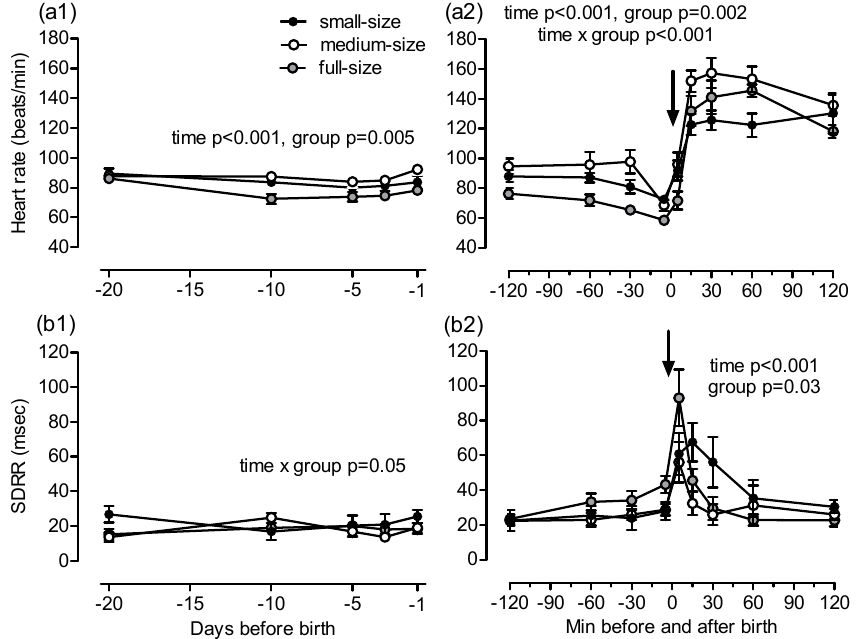
Figure 5. ( a ) Heart rate and ( b ) SDRR (standard deviation of the beat-to-beat interval) in small (Shetland), medium-size (Haflinger) and full-size (Warmblood) fetuses ( 1 ) during the last 20 days before birth and ( 2 ) in the same animals from 120 min before to 120 min after birth (arrow). Significant differences are indicated in the figures; for pairwise post-hoc comparisons see text.